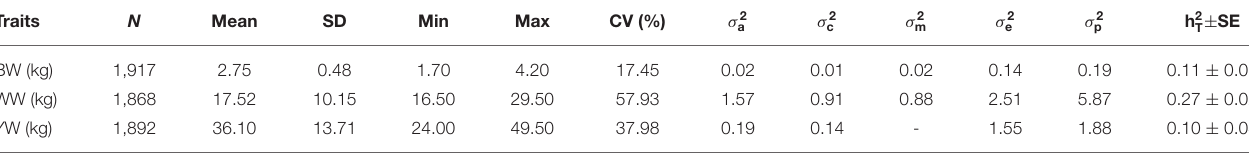
TABLE 1 | Descriptive statistics and variance components of body weight traits in Inner Mongolia cashmere goats.